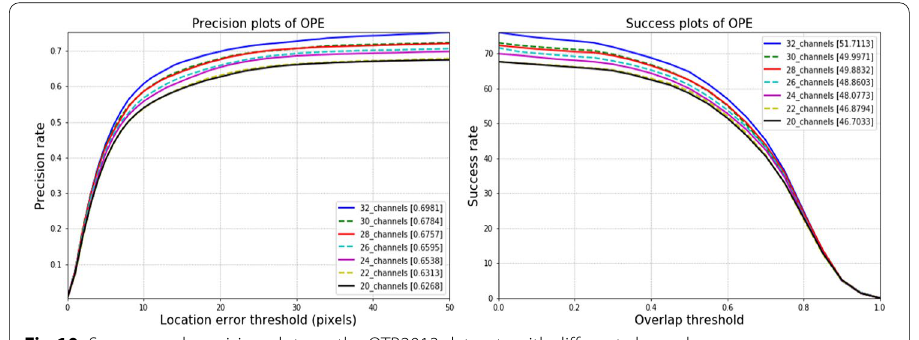
Fig.10 Success and precision plots on the OTB2013 datasets with different channels